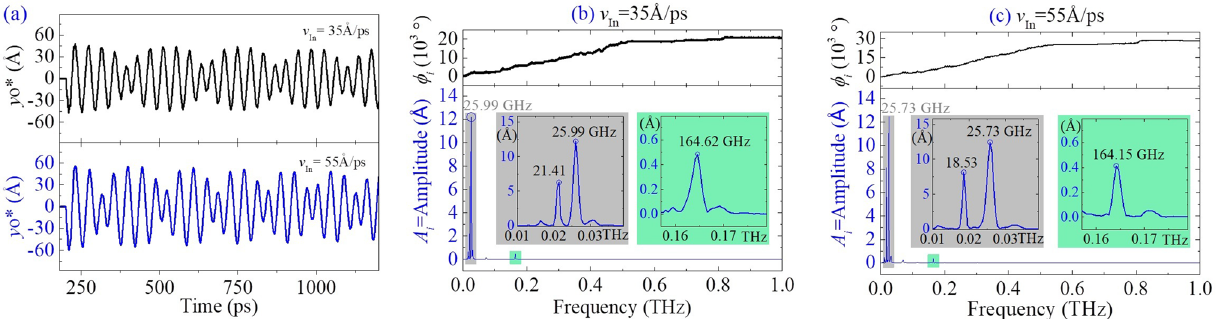
Figure 4. FFT results of yo*(t) curves with respect to different incident velocities. ( a ) Vibrations of the beam in the yz-plane when v In = 35